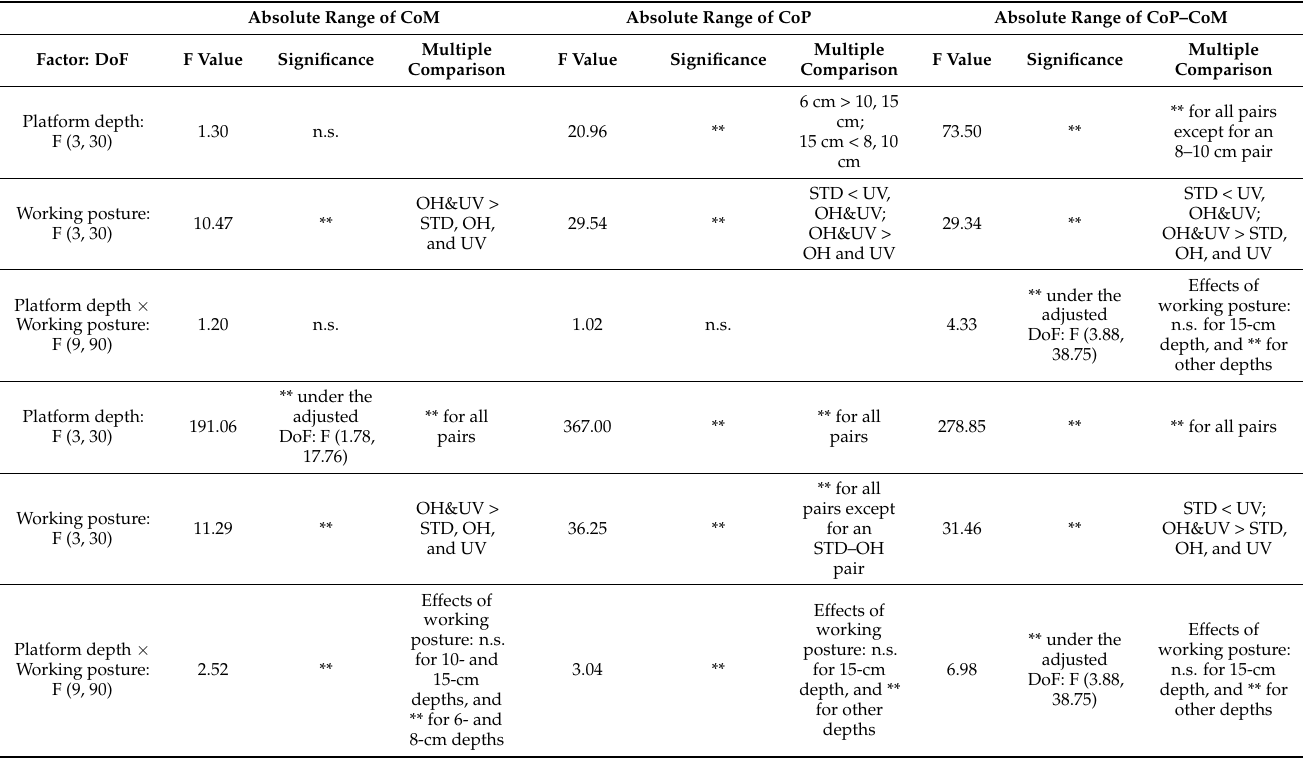
Table A1. Results of repeated measures ANOVA for the kinematical indices and the subjective sense of instability (** p < 0.01. *: p < 0.05; n.s.: not